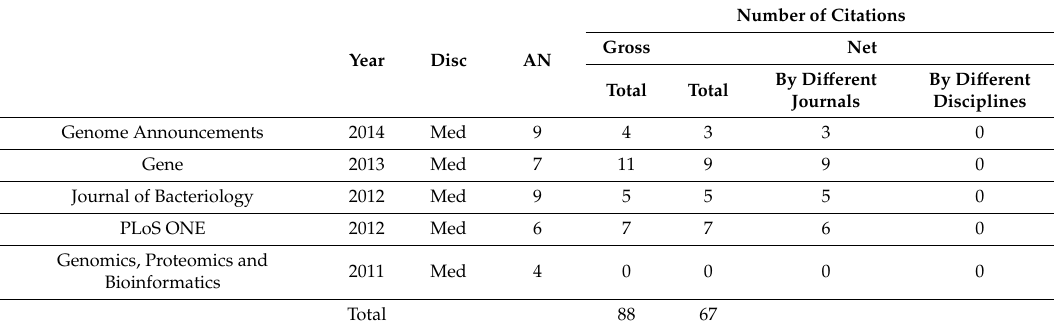
Figure A2. Characterization of a randomly chosen author for health sciences. Black area (15.3%) = networking; red area (0.2%) = intradisciplinary and intratopical heterodox; yellow area (86.2%) = intradisciplinary and intertopic orthodox; blue area (0%) = interdisciplinary and intertopical orthodox. G d = 0, G j = 0.97, H ldn = 0.03, H ljn = 1.00, H ltn = 1.10, H ltg = 1.30. Abbreviations: G d , Gini index for disciplines; G j , Gini index for journals; H , Hirsch indexes; d = discipline, g = gross, j = journal, l = linear, n = net, t = total.